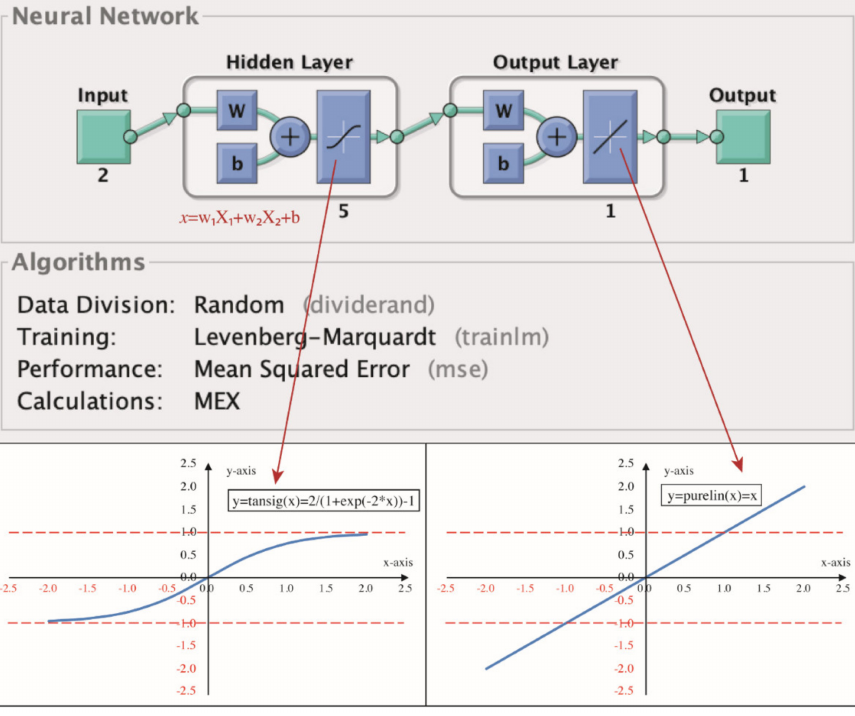
Figure 5. Algorithms of the back propagation artificial neural